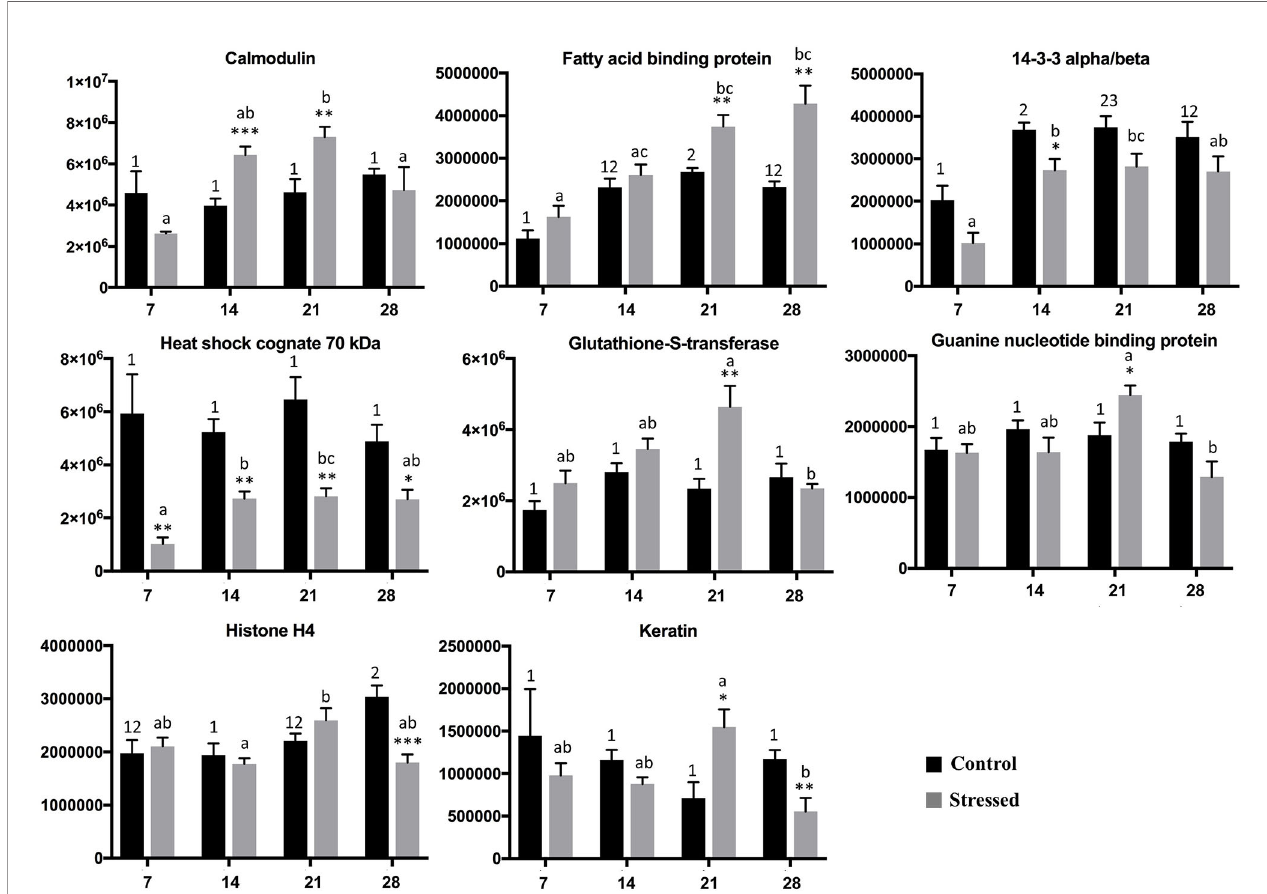
FIGURE 4 | Protein spot intensities of identi fi ed proteins in control and stressed group. Protein spot intensities given by PDQuest (Y-axis) during the course of the experiment measured on day 7, 14, 21, and 28 (X-axis). Error bar shows error of mean (p < 0.05, n = 6). Letters signi fi es the difference in expression between the stressed group and number signi fi es the difference in expression between the control group along the course of experiment at different time points (One way Annova and Tukey HSD post hoc analysis; Kruskal Walli ’ s test and Dunn ’ s test for nonparametric data). The same number/letters shows no difference and different number/ letters indicates a difference. Asterisk shows the comparison between the control and stressed fi sh at each time point (unpaired t-test for data that showed normal distribution and Mann Whitney U test for data that did not show normal